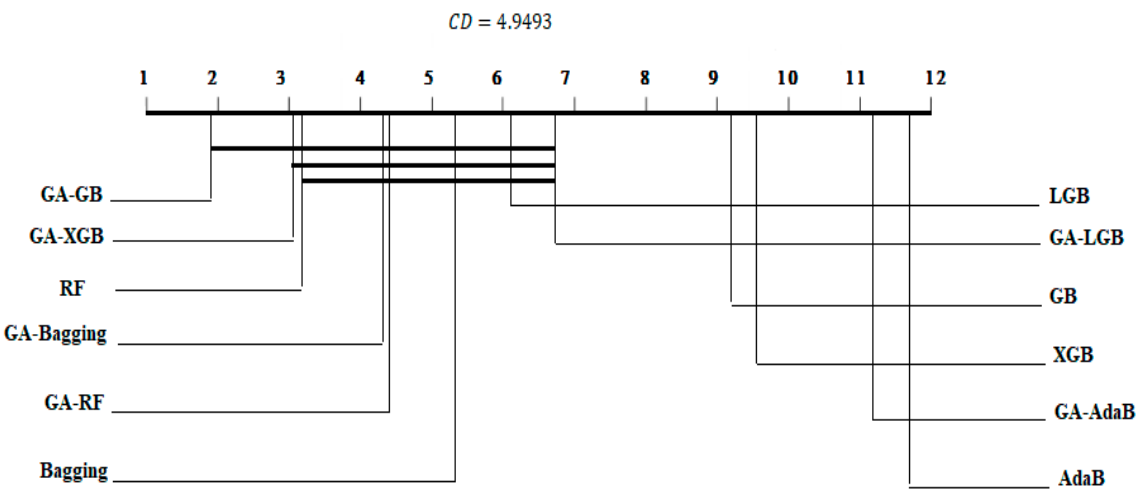
Figure 9. Critical difference diagram of Dataset 1 for the Nemenyi test.